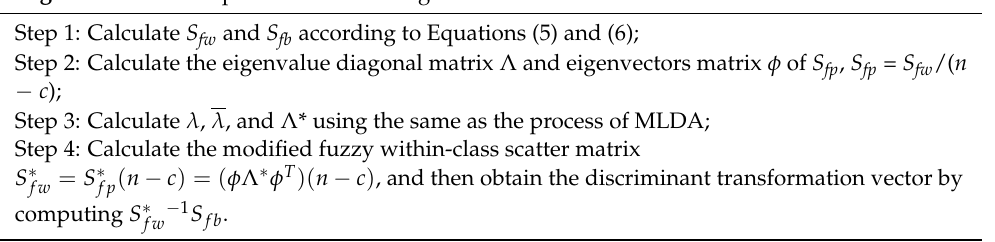
Algorithm 2: The steps of the FMLDA